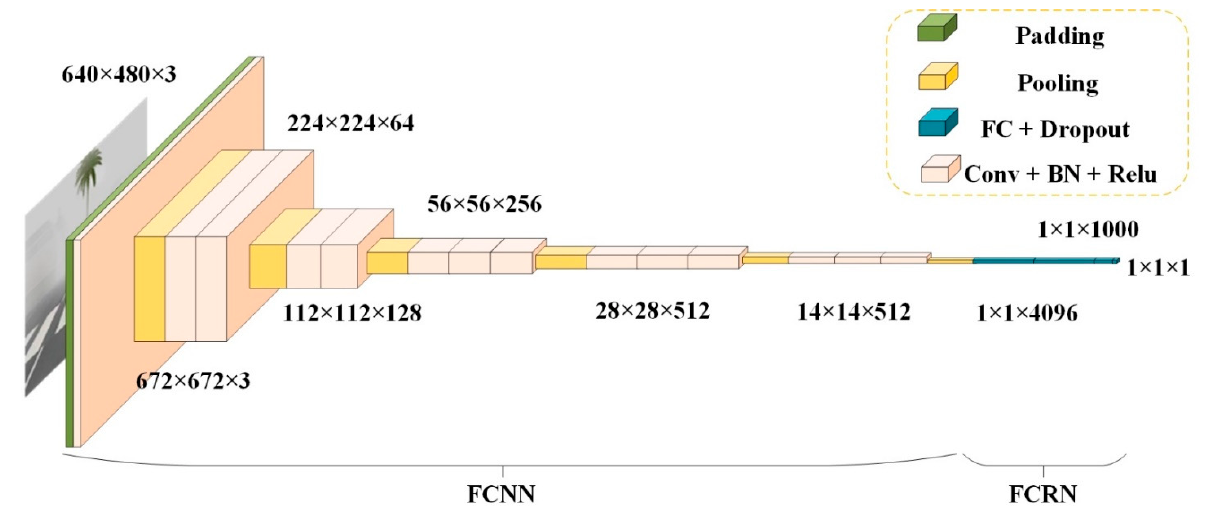
Figure 3. Structural diagram of the feature extraction and regression module (FERM).